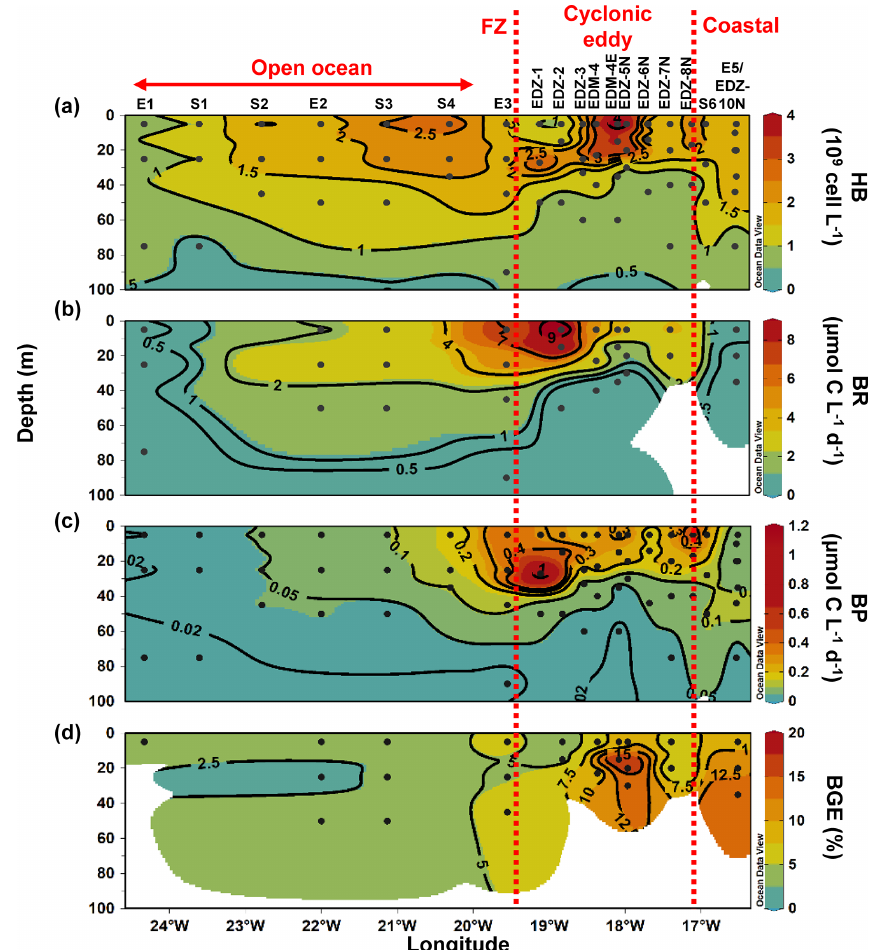
Figure 5. Depth distribution of heterotrophic bacterial abundance and activities from the surface to 100m. Heterotrophic bacterial abundance (HB; a ), bacterial respiration (BR; b ), bacterial production (BP; c ), and bacterial growth efficiency (BGE; d ). Dashed red lines show the western and eastern boundaries of the cyclonic eddy periphery. FZ refers to frontal zone. BP and CR rates at in situ temperature were estimated based on López-Urrutia and Morán (2007) and on Regaudie-de-Gioux and Duarte (2012). BR rates were estimated from measured and temperature-corrected CR rates based on Aranguren-Gassis et al. (2012). Details are provided in the methods section and the Supplement.